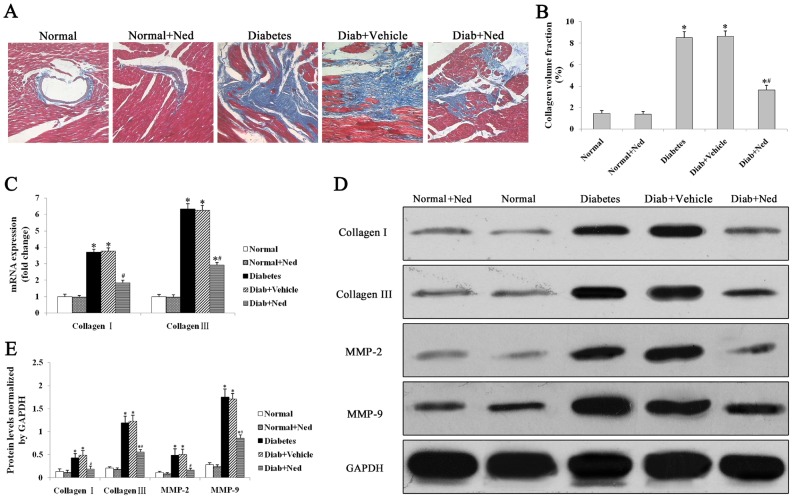
Collagen deposits in the left ventricle (LV) of normal and STZ-induced diabetic mice after nedocromil (Ned) treatments.(A) Representative images of LV sections stained with Masson's trichrome at 100X magnification. Blue color indicates collagen deposits. (B) Quantification of LV collagen volume fraction (CVF). CVF is represented as the ratio of collagen area/total area. (C) The mRNA expression levels of type I and type III collagen are normalized to GAPDH expression and depicted as fold-change relative to the untreated normal group. (D) Representative results of protein expression analysis for collagen I, collagen III, MMP-2, and MMP-9 in sample tissues using western blot. GAPDH expression is shown as loading control and used for normalization. (E) Quantification of type I and type III collagen, MMP-2, and MMP-9 protein levels normalized to GAPDH. Quantitative data are displayed as means ± SD (n = 15 per group). *P<0.05 vs. untreated normal group; #P<0.05 vs. untreated diabetic group.